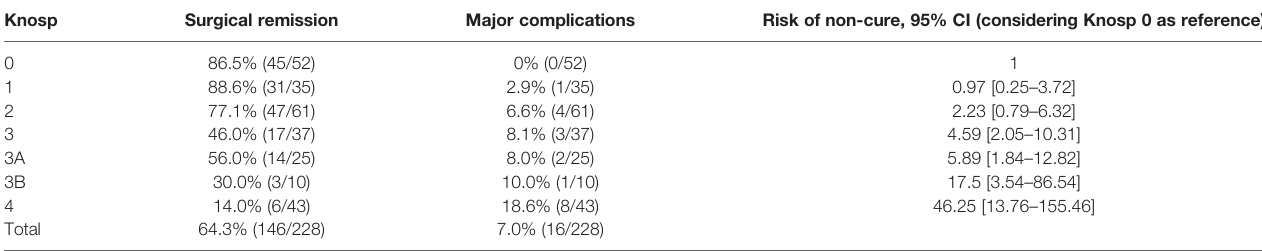
The chances of non-cure increased as the Knosp grade increased [MH Test for linear Trend: c 2 = 73.1 (p = 0.0000)].